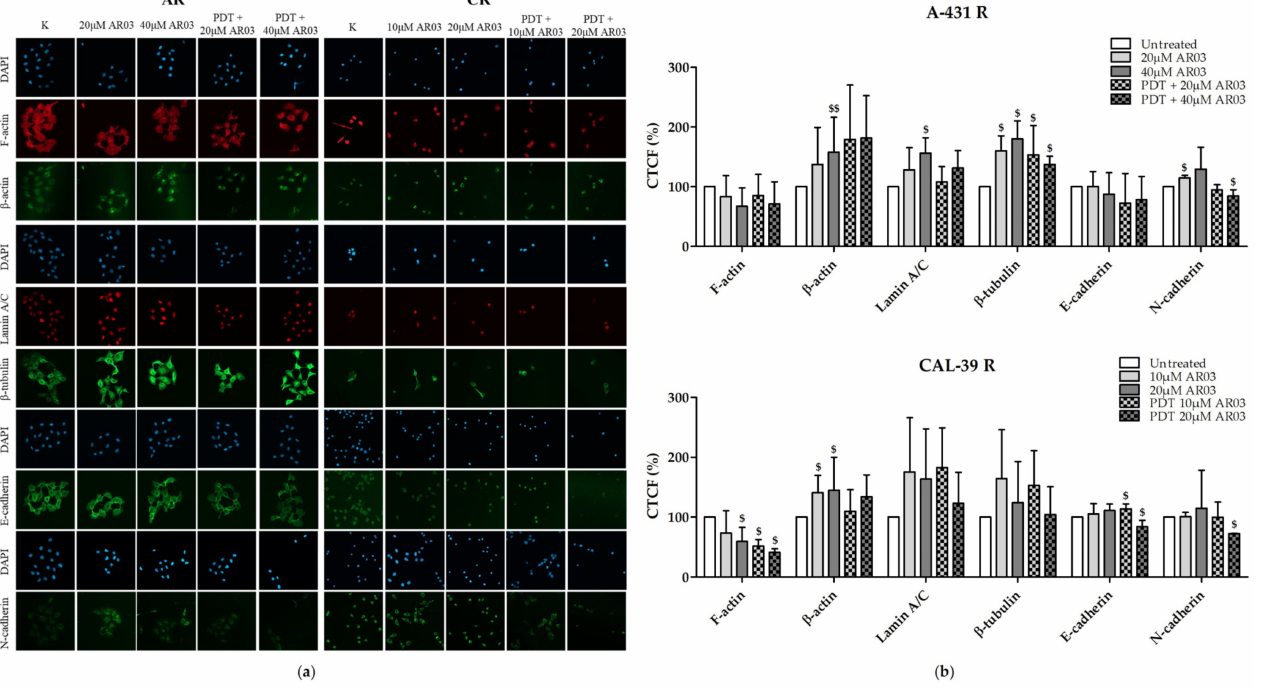
Figure 10. Effect of AR03 on cytoskeleton and lamin A/C. ( a ) Images of stained cells before treatment, after AR03 treatment, or after PDT combined with AR03 treatment. Pictures were taken by the use